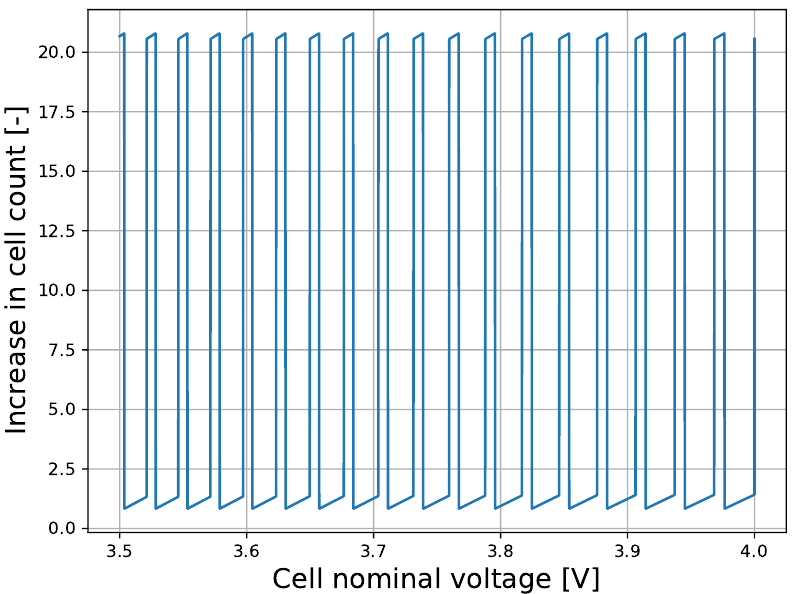
Figure 15. Relation between cell voltage and the increase in the number of cells with respect to the number before taking the configuration into